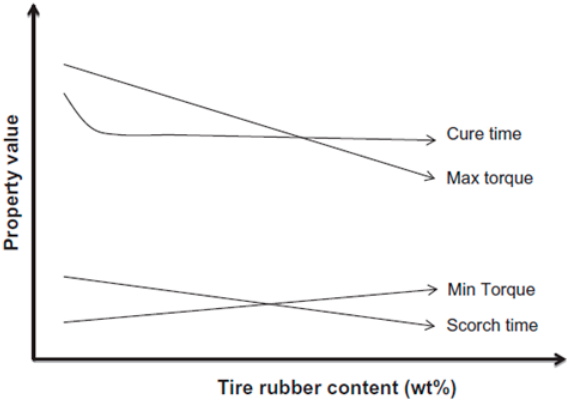
Figure 19. Effect of tire rubber content on the cure characteristic of rubber blends (reproduced with permission from [16]).